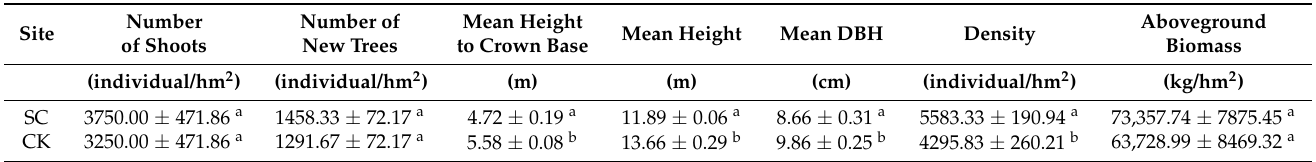
Table 1. Basic information of different treatment plots in